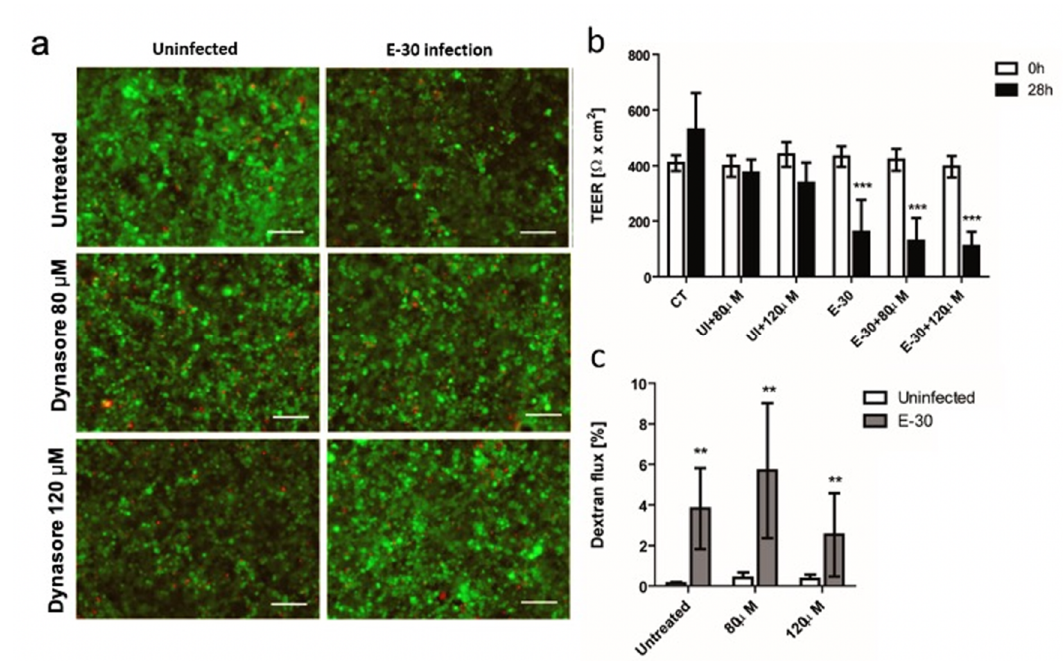
Figure 10. Blocking of dynamin-mediated endocytosis with Dynasore has no impact on the loss of barrier properties of HIBCPP cells following E-30 infection. ( a ) Dynasore and E-30 infection have no drastic impact on HIBCPP cells viability. Live/dead assay stains living cells in green and dead cells in red. Pictures show representative images from 3 independent experiments, each performed in duplicates for the following conditions: uninfected and untreated (CT), 80 μM of Dynasore in uninfected condition (UI + 80 μM), 120 μM of Dynasore in uninfected condition (UI + 120 μM), E-30 infection no blocking (E-30), 80 μM of Dynasore and E-30 infection (E-30 + 80 μM), and 120 μM of Dynasore and E-30 infection (E-30 + 120 μM). ( b ) TEER decrease after E-30 infection in presence or absence of Dynasore. TEER was monitored at T = 0 h (white bars) and T = 28 h (black bars) of blocking with Dynasore, for all the conditions. ( c ) Increased dextran flux following E-30 infection in presence or absence of Dynasore. Quantification via fluorescent measurement of paracellular flux with dextran-TexasRed (MW 1000 Da), from T = 24 h to T = 28 h of blocking with Dynasore for all the conditions. Statistical significance was calculated using a Student’s t -test. p values are displayed as follows: ** p < 0.05 and *** p < 0.001 was reached comparing the mean of uninfected values ± blocking with the corresponding values in E-30 infection. White scale bars represent 100 μM.